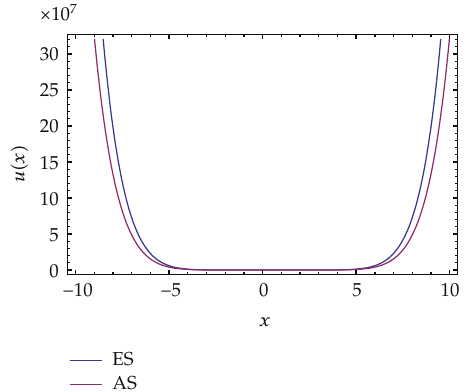
Figure 8: The compared results of the analytical and numerical solutions of Example 4.3 for t (cid:3) 1 . 0.